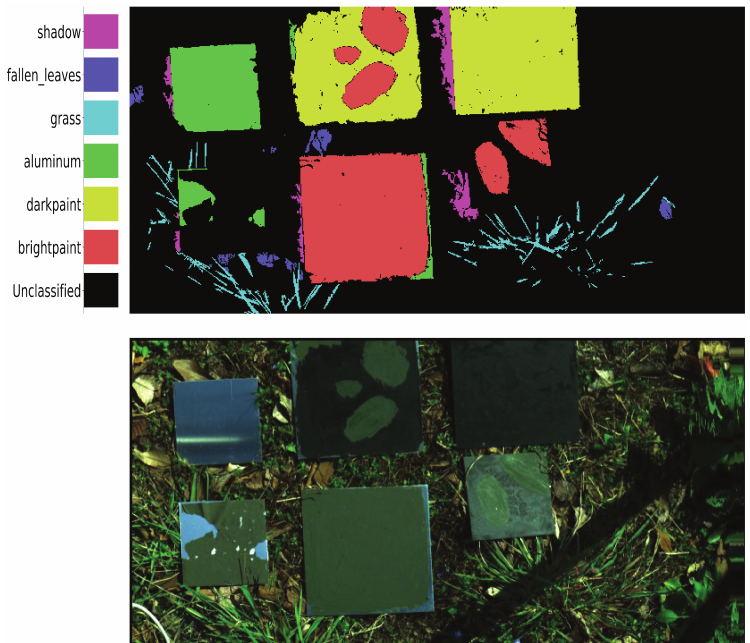
Figure 11. YU Paint dataset: Left is the names of classes, Top is ground truth, Bottom is the RGB image.